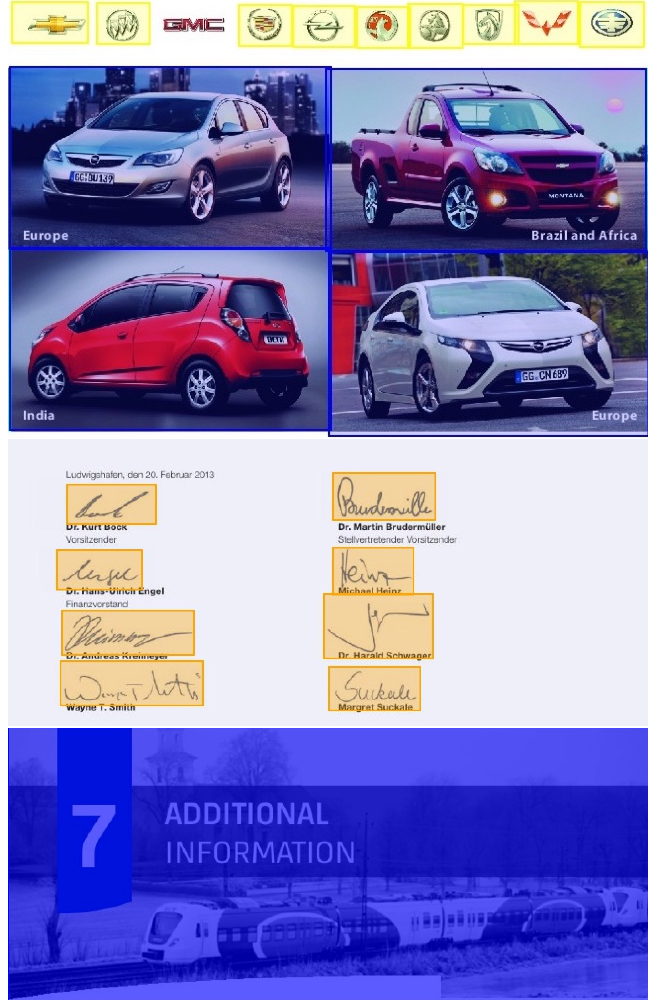
Figure 2. Challenges of graphical page object detection. Natural images are outlined in blue, logos in yellow, and signatures in orange. Natural images and signatures have text superimpositions in the second and third rows. The natural image in the fourth row has text and vector graphic